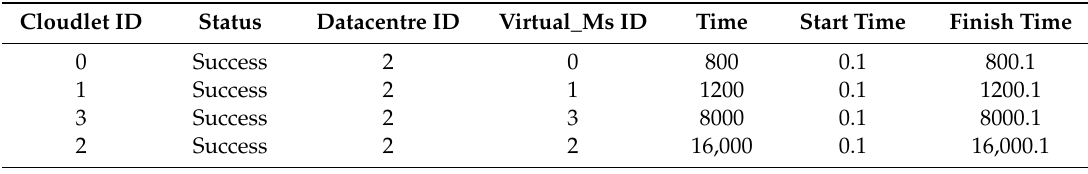
Table 8. Outputs of default CloudSim, first trial.